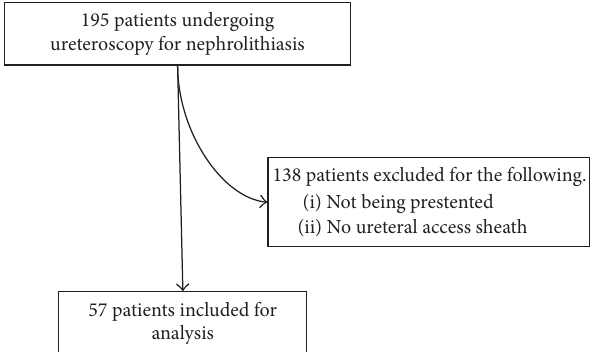
Figure 1: Patient selection, inclusion, and exclusion.